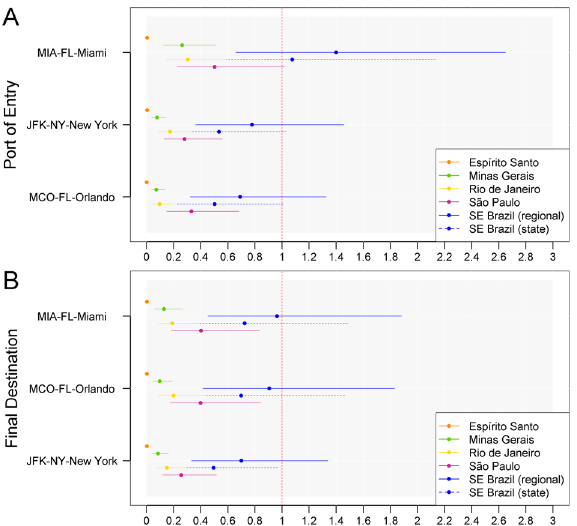
Figure 2. Baseline risk of YFV importation into the United States in 2017–2018. Mean and 95% confidence AW interval of the estimated total number of YFV importations ( I , comprising incoming Brazilian travelers, S , S returning US travelers and international travelers) entering the United States at the specified ports of entry ( A ) and final destination airports ( B ) during the 2017–2018 YF outbreak. Only US airports with an upper 95% confidence limit exceeding 0.5 over all Brazilian states in Southeast Brazil (regional estimate) are shown. These estimates were obtained assuming 70% vaccination coverage of US and international travelers to Brazil. Uncertainty derives from sampling 10,000 stochastic realizations of the length of stay, incubation period, infectious period, number of asymptomatic or mild infections for each severe YFV case and vaccine efficacy from their respective distributions. SE Brazil = Southeast